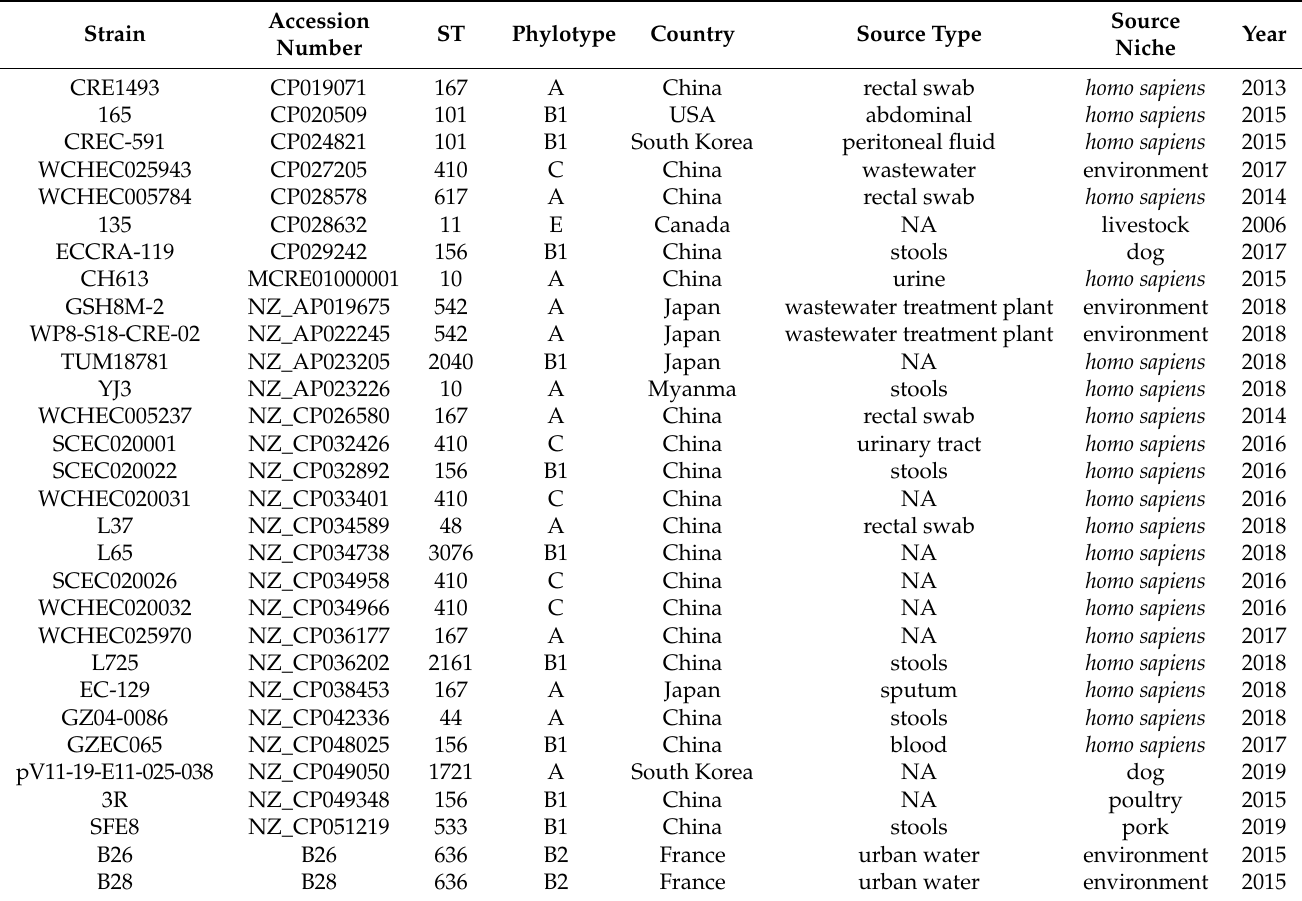
Table 2. Characteristics of E. coli genomes carrying a bla NDM-5 IncX-3